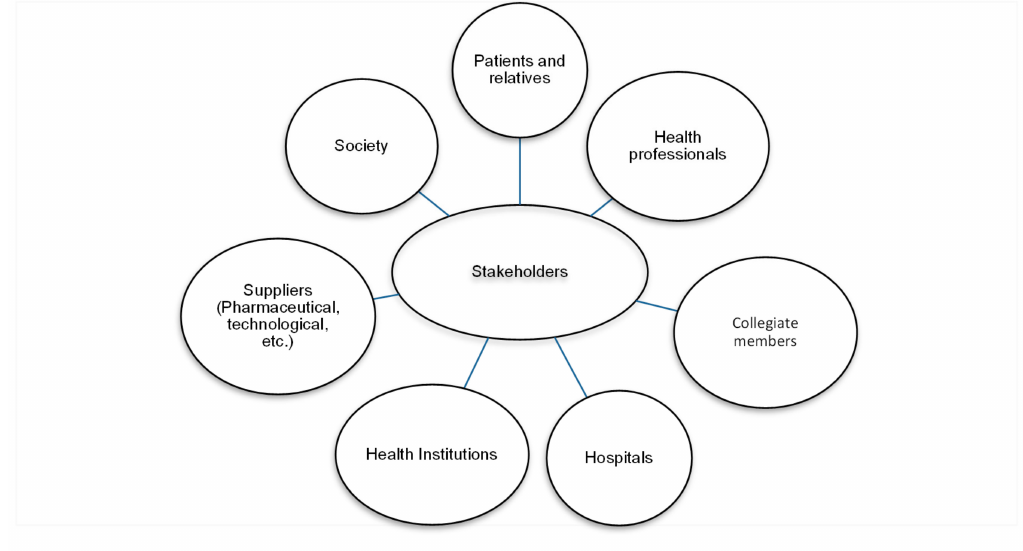
Figure 2. Stakeholders of Spanish o ffi cial medical colleges. Source: Adapted from Freeman